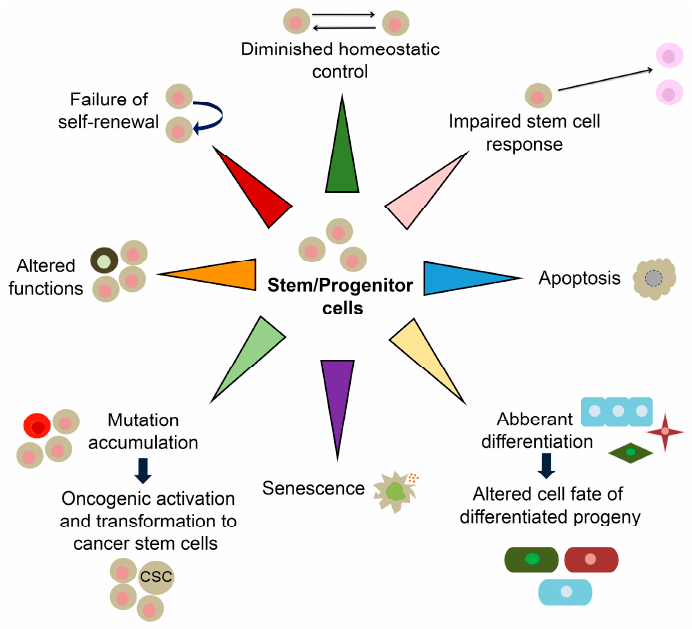
Figure 2. Schematic representation of molecular features of aged stem/progenitor cells. CSC-cancer stem cell. The scheme is based on the previously reported publications [51,52].